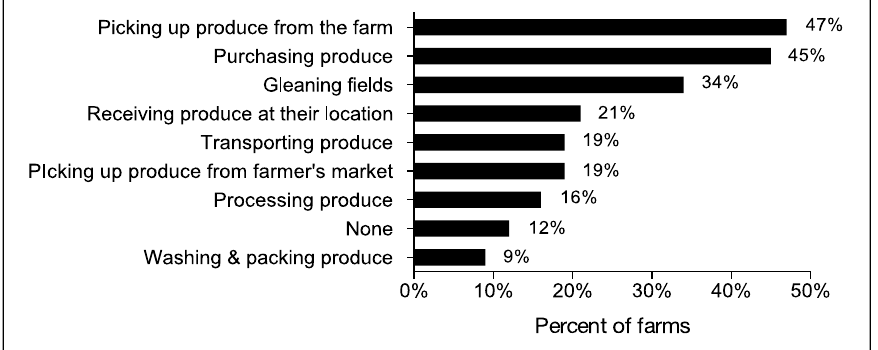
Figure 4. Services Participating Farmers Would Appreciate from Community Groups, Vermont,